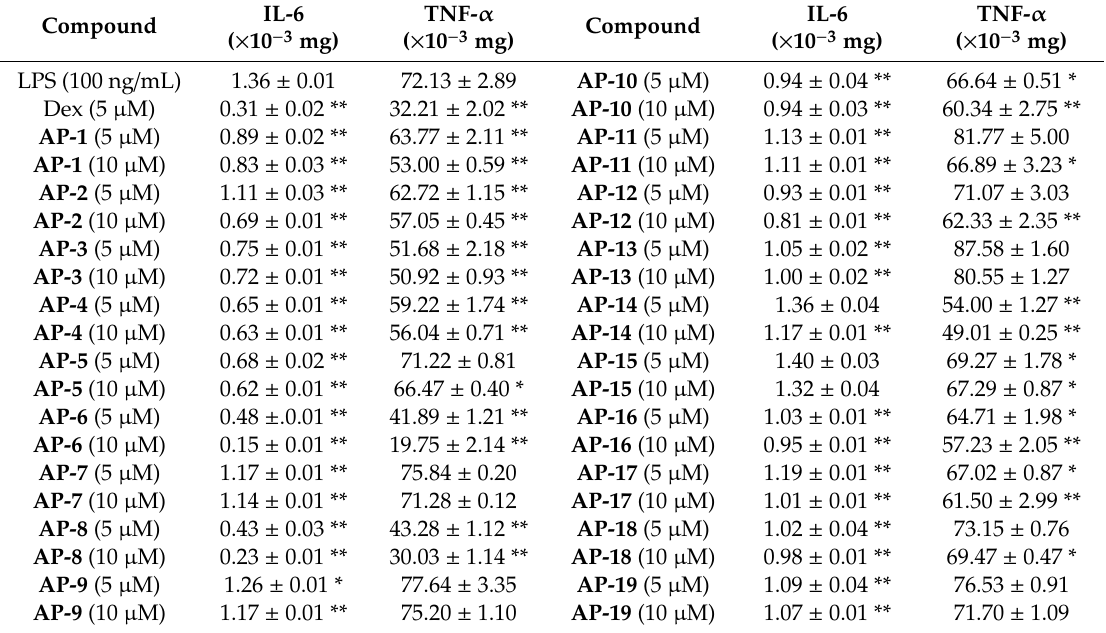
Table 3. Anti-inflammatory e ff ects of 19 diterpenoid lactones on LPS-stimulated RAW 264.7 cells. Compound